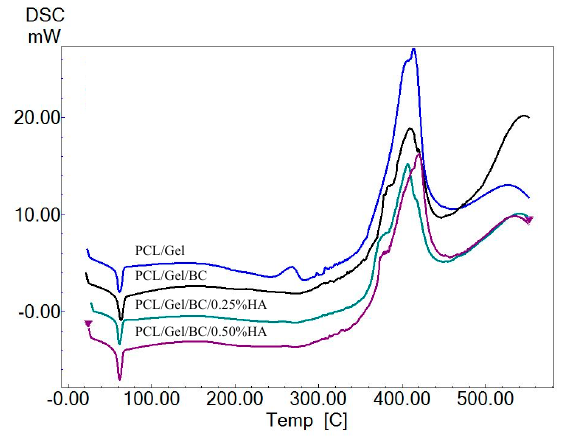
Figure 4. DSC thermogram of PCL/GEL, PCL/GEL/BC, PCL/GEL/BC/0.25%HA, and PCL/GEL/BC/0.50%HA scaffolds.